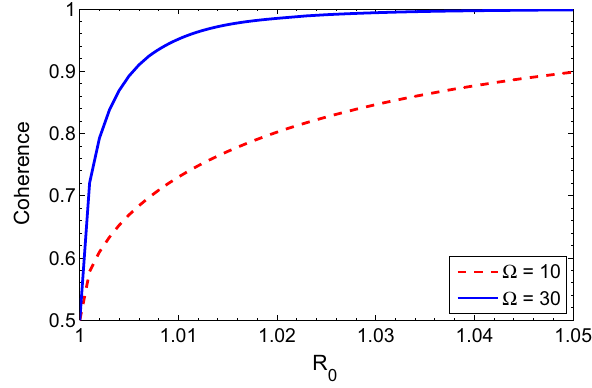
Fig. 2 The quantum coherence as function of R 0 . The maximally ) = 1 has been chosen as an initial state coherent state with C (ρ B 0 of fall free particle. The relative distance of Bob to event horizon is R 0 ≤ 1 . 05, so Rindler approximation can be